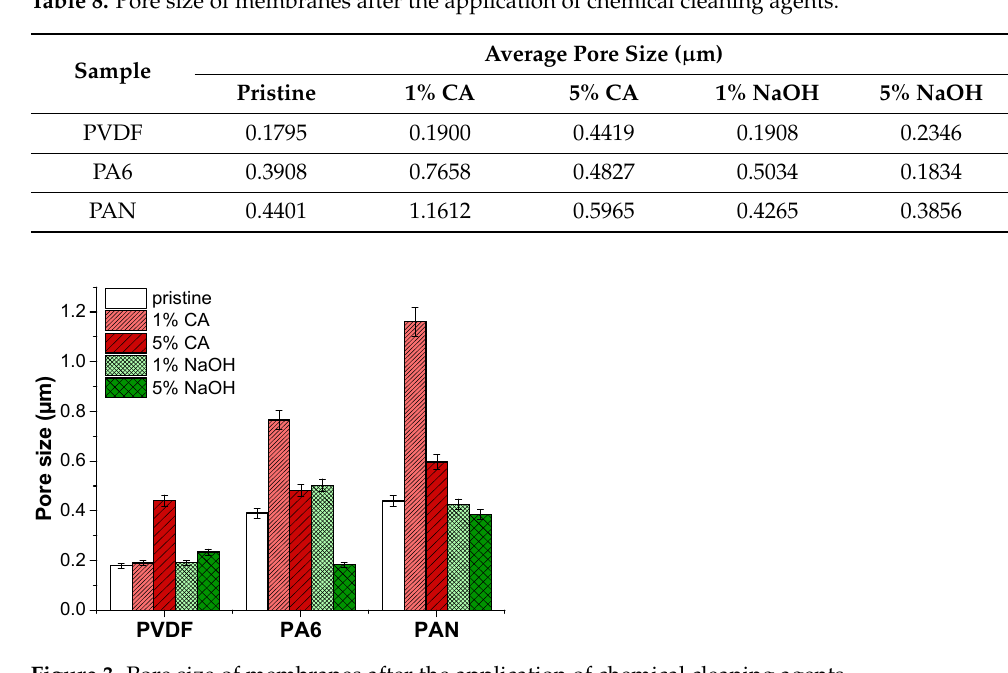
Figure 3. Pore size of membranes after the application of chemical cleaning agents.